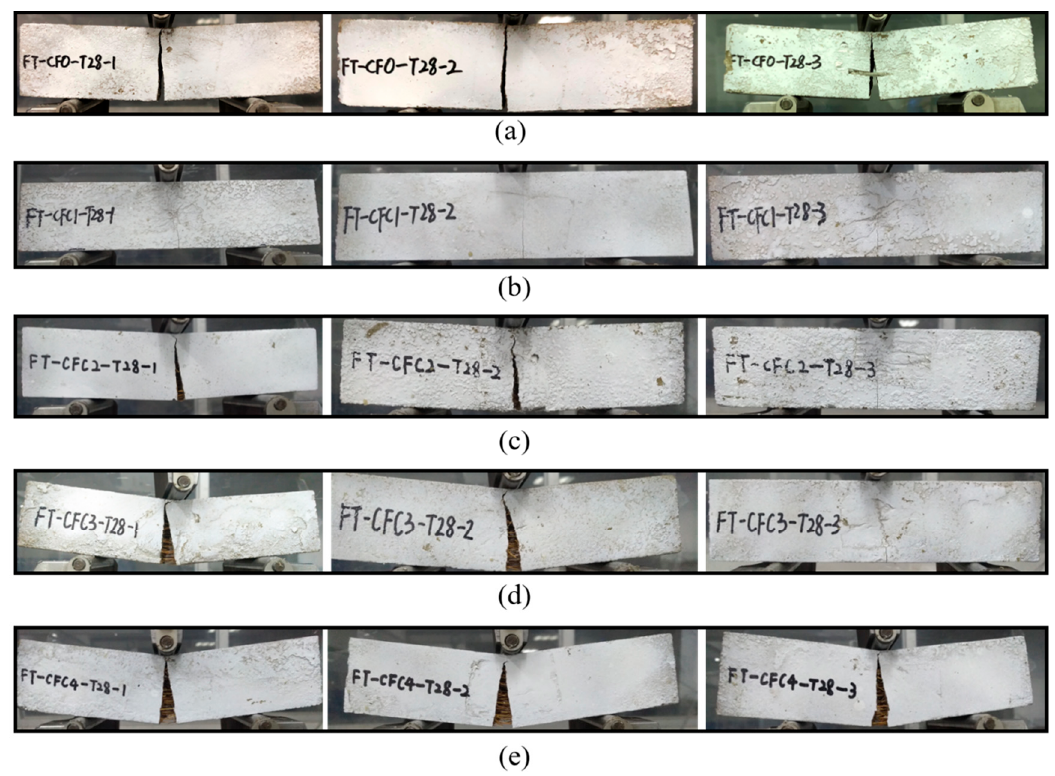
Figure 6. Failure modes of group T28. ( a ) CF0-T28; ( b ) CFC1-T28; ( c ) CFC2-T28; ( d ) CFC3-T28; ( e ) CFC4-T28.